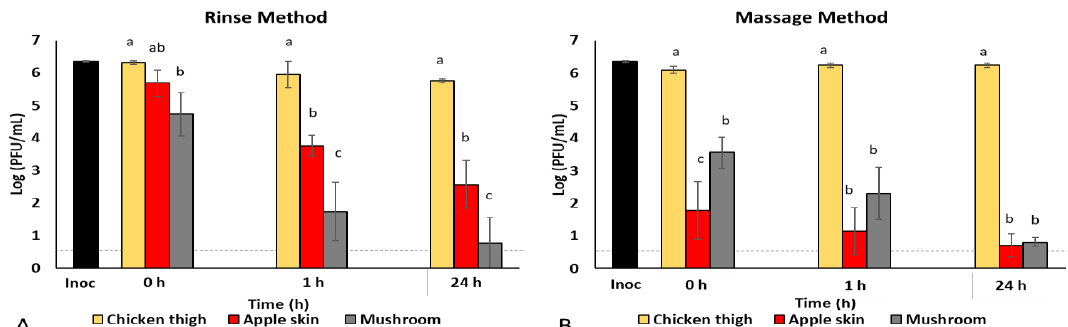
Figure 1. Rinse versus massage method comparison. Herpes simplex virus (HSV-1) was recovered from chicken thigh, apple skin, and mushrooms incubated at 4 °C for 0 h, 1 h, and 24 h using ( A ) rinse method and ( B ) massage method, quantifying infectious virus titer by standard plaque assay on Vero 76 cells and shown as log PFU/mL ( n = 3). Inoculum (Inoc) titer is shown as PFU/sample (log); 10 µL of a 2.3 × 10 8 PFU/mL stock ( ≈ 2.5 × 10 6 PFU/sample) were inoculated onto each food sample. The dashed line indicates the detection limit (0.7 log or 5 plaques/mL) of the viral plaque assay. a–c Means within an incubation time that have a common lowercase letter are not significantly different ( p < 0.05). Table 1. HSV-1 Rinse vs. Massage.